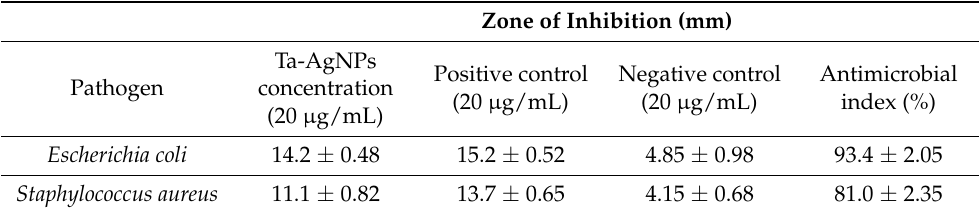
Table 1. Assessment of antimicrobial activity of Ta-AgNPs against pathogenic